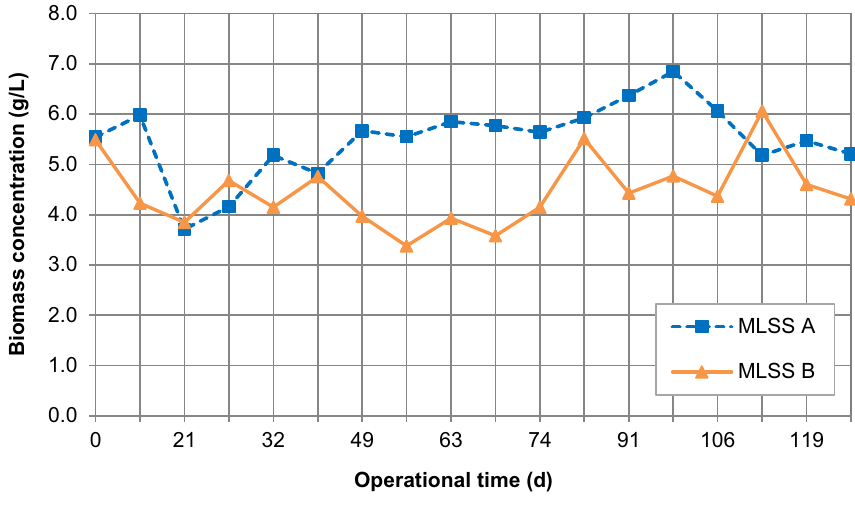
Fig. 2 Profile of biomass con- centrations (MLSS) for SBR A and SBR B